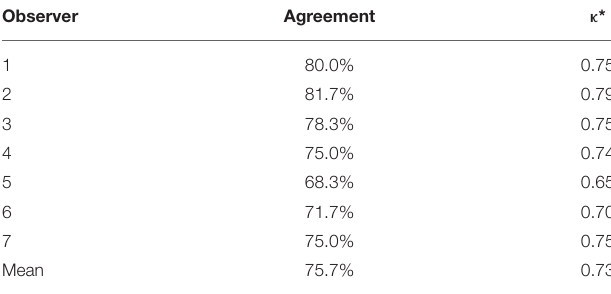
TABLE 3 | Intraobserver